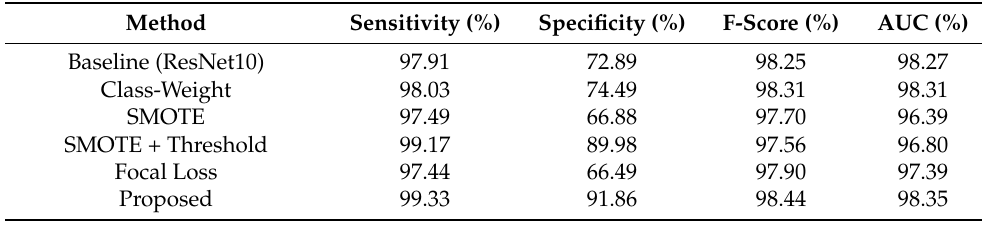
Table 5. Comparison of imbalance algorithm of ResNet